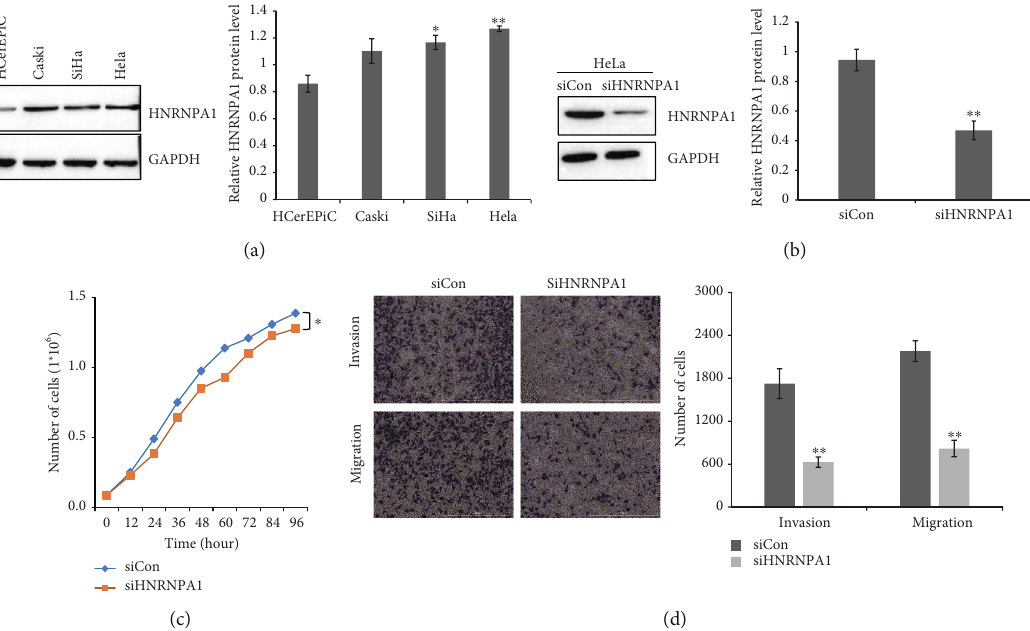
Figure 1: Knockdown of HNRNPA1 attenuated the proliferation, invasion, and migration of HeLa cells. (a) Western blot results showed the expression of HNRNPA1 in normal cervical epithelial cells (HCerEPiC) and HPV-associated cervical cancer cells (HeLa cells, Caski cells, and SiHa cells). The relative intensities of HNRNPA1/GAPDH were quanti fi ed using ImageJ. ∗ P < 0 : 05 ; ∗∗ P < 0 : 01 . (b) HNRNPA1 expression was measured by western blot in HeLa cells stably expressing nontargeting control (siCon) and siHNRNPA1. The relative intensities of HNRNPA1/GAPDH were quanti fi ed using ImageJ. ∗∗ P < 0 : 01 . (c) E ff ects of HNRNPA1 on HeLa cell proliferation were determined by CCK-8 kits. ∗ P < 0 : 05 . (d) Transwell assay was performed to determine the invasion and migration of HeLa cells. The invasion and migration of HeLa cells were quanti fi ed using Image-Pro Plus 6.0. ∗ P < 0 : 05 ; ∗∗ P < 0 : 01